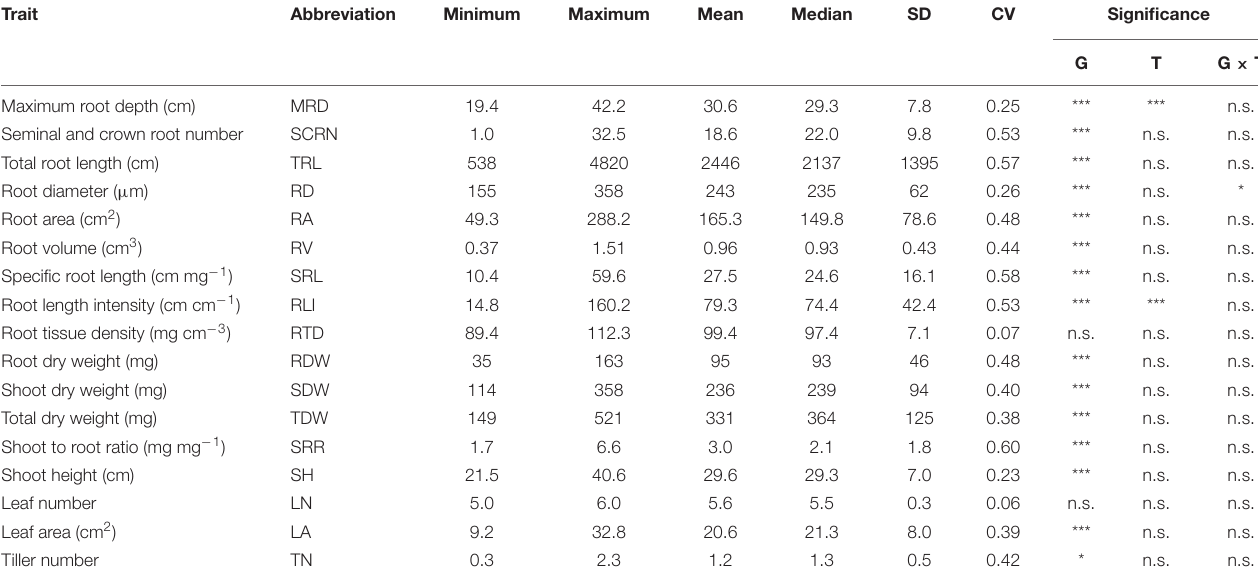
TABLE 5 | Descriptive statistics of 17 shoot and root traits (referred as major traits) in six rice genotypes with and without root cutting treatment grown in a semihydroponic phenotyping platform for 41 days after transplanting.